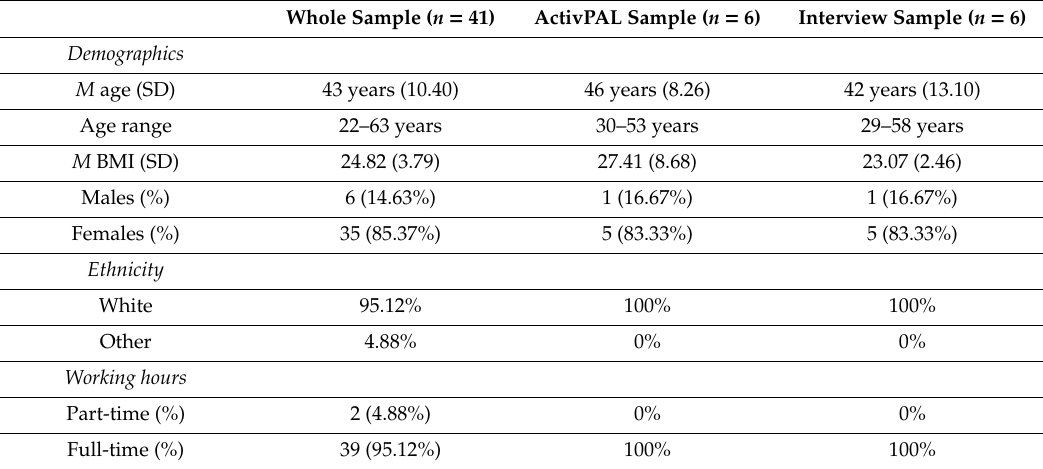
Table 1. Participant